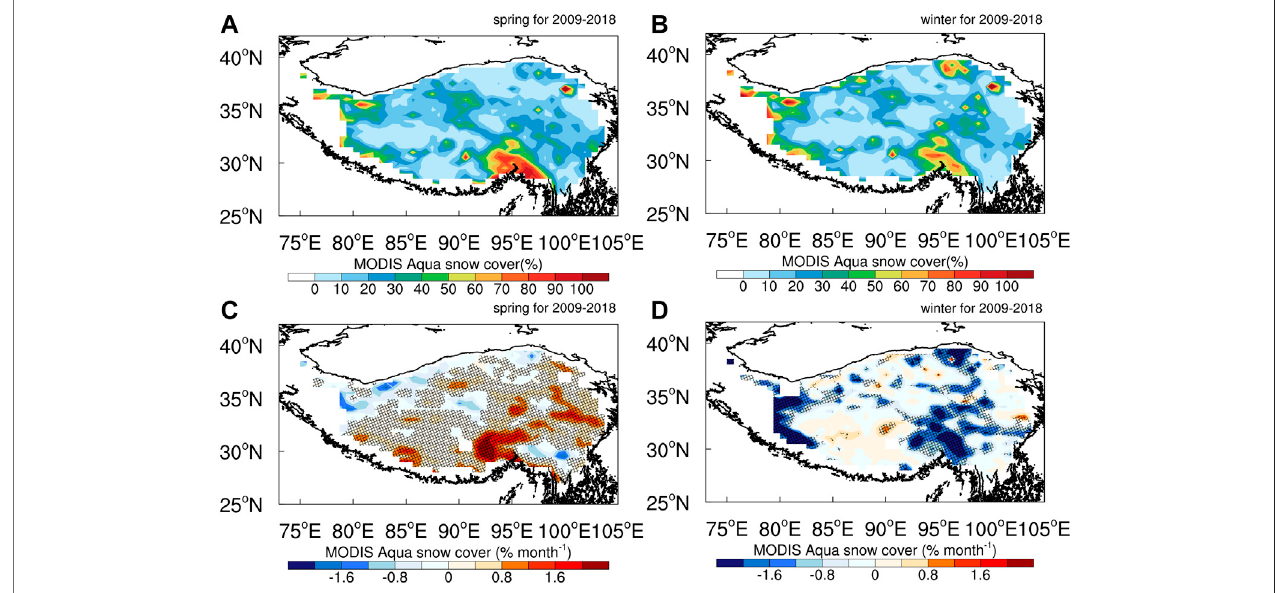
FIGURE6| Spatialdistributionsofsnowcover(units:%)overtheTPin (A) MAMand (B) DJFfor2009 – 2018derivedfromMODISretrievals. Spatial distributions of snow cover trends (units: % month − 1 ) over the TP in (C) spring (MAM) and (D) winter (DJF) for 2009 – 2018 derived from MODIS retrievals. Regions passing the 95% signi fi cance level are highlighted by stipple. Signi fi cance is assessed through the t value of the ensemble trend.